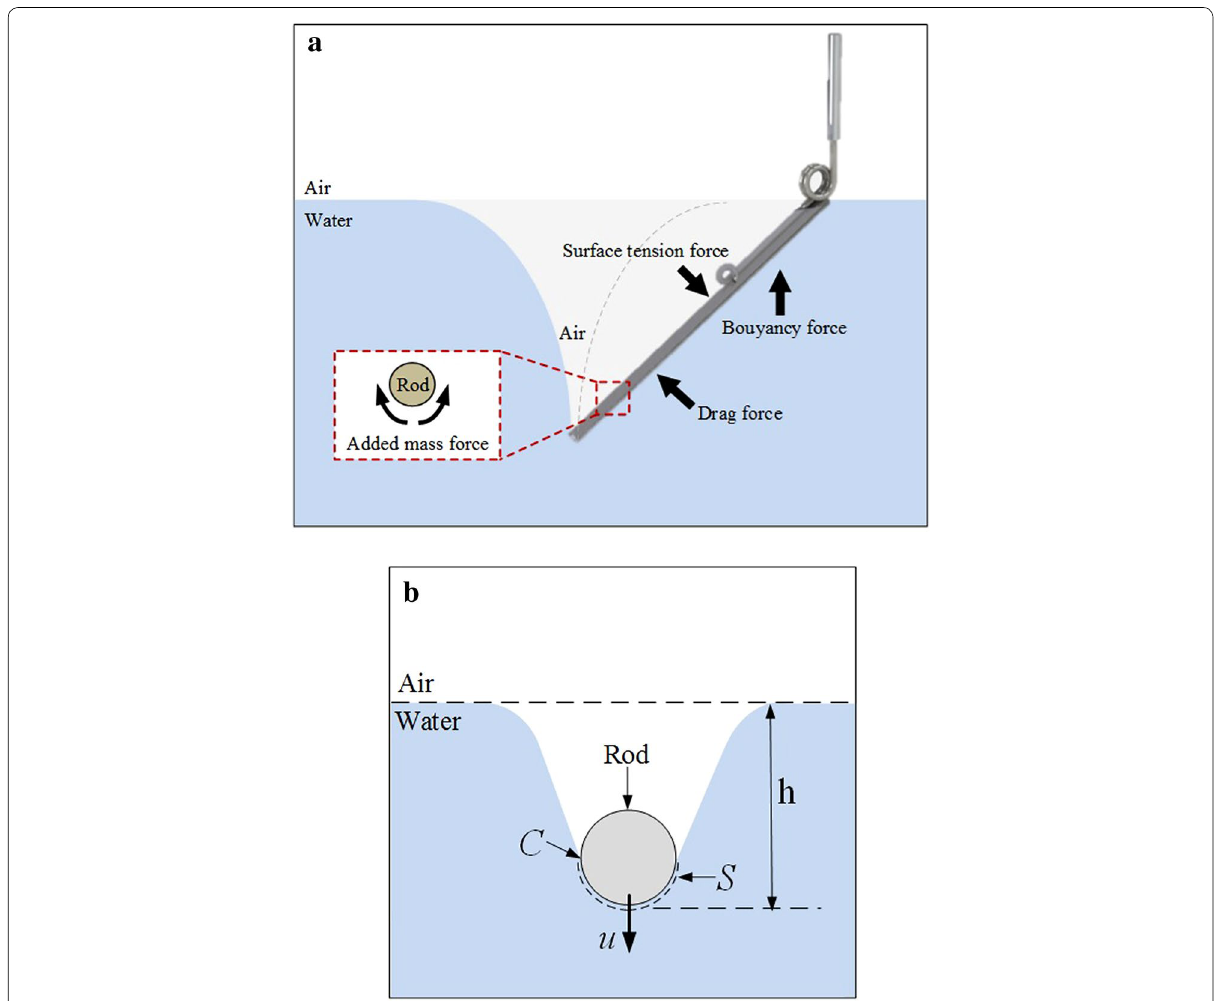
Fig. 1 Four major reaction forces acting on a rotating carbon rod ( a ) and its cross section ( b